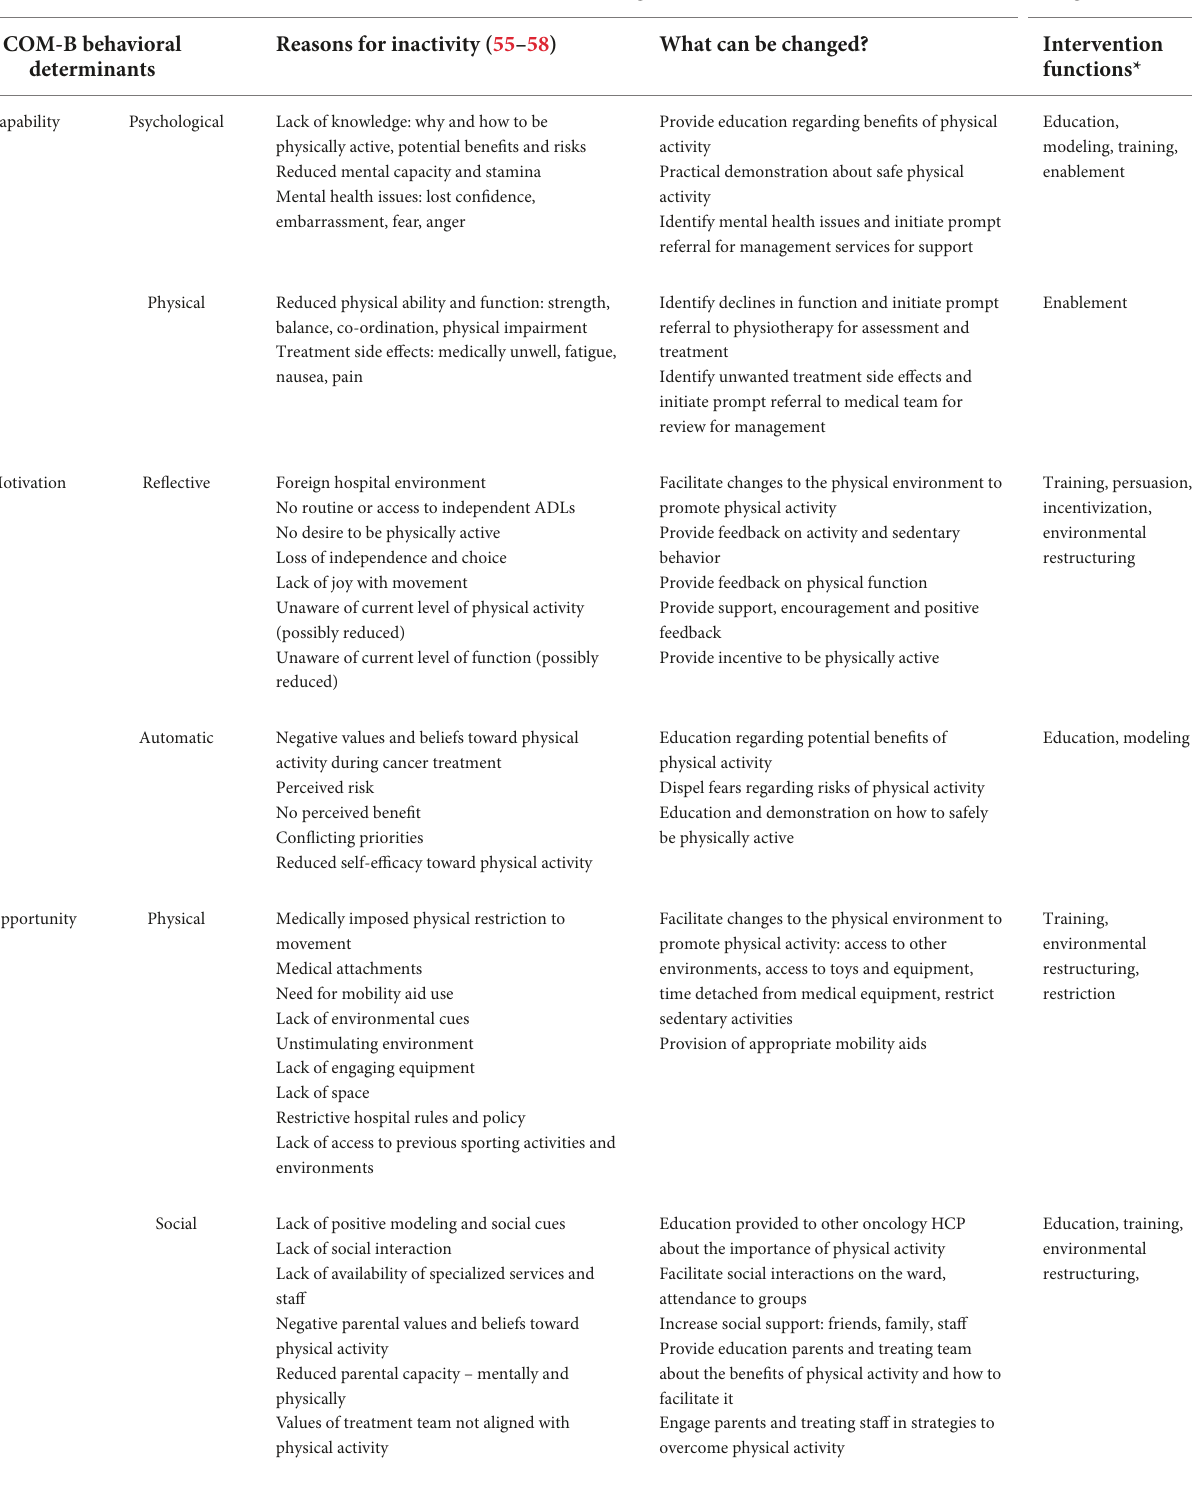
TABLE 1 Behavior Change Wheel stage 1 and